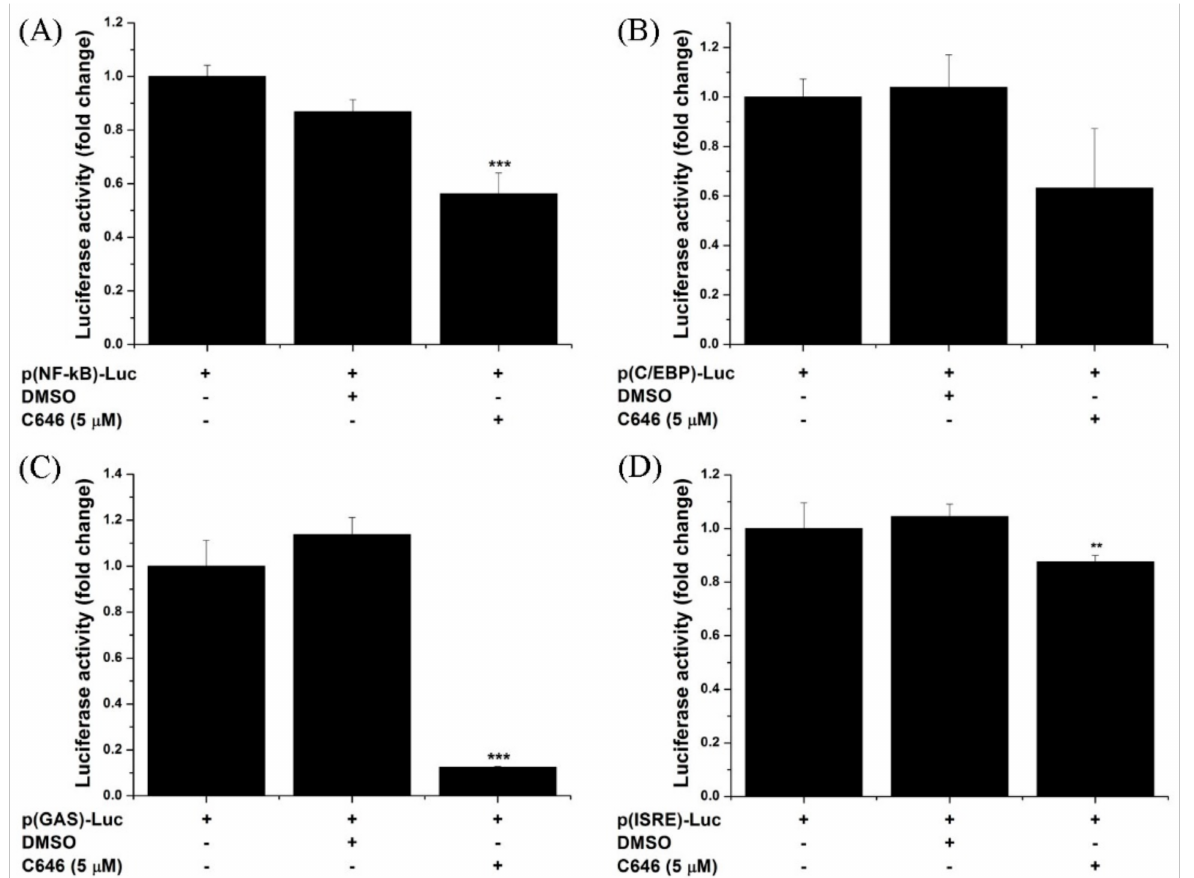
Figure 7. P300/CBP-dependent regulation of the luciferase level directed by the activation of ( A ) NF-kB, ( B ) C/EBP, ( C ) GAS, and ( D ) ISRE enhancer elements in HEK293 cells transfected with the corresponding transcription factor cis -